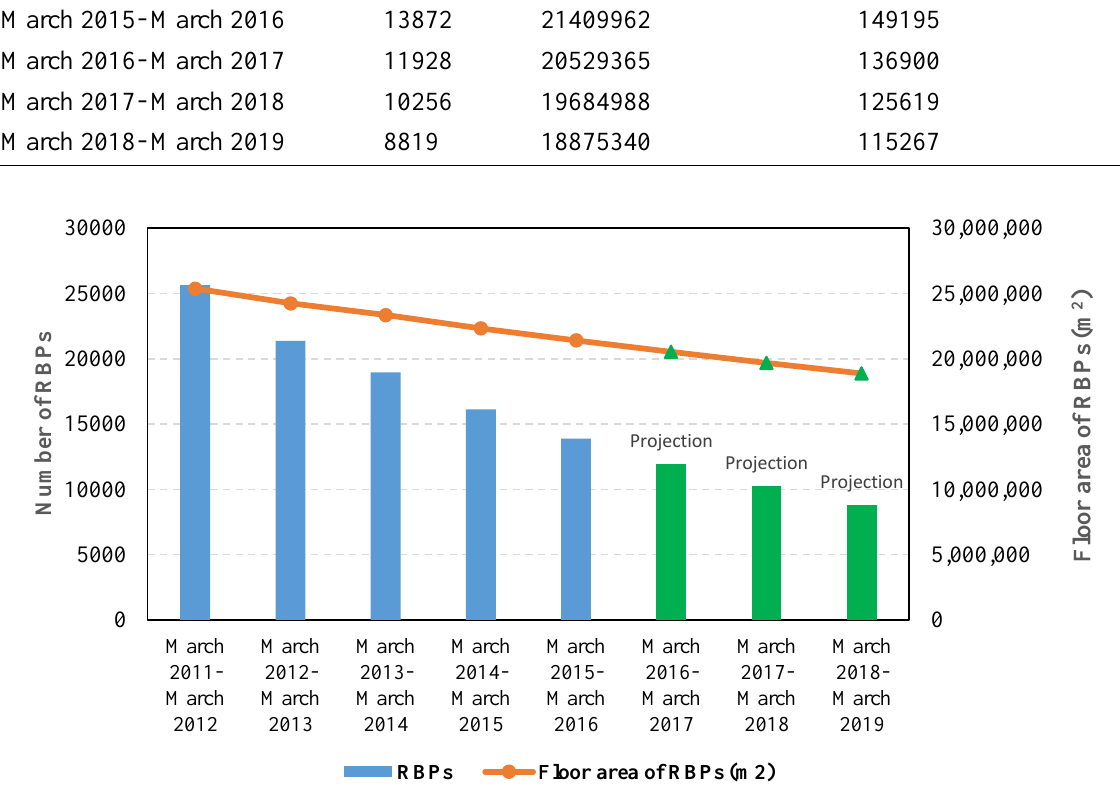
Figure 1 . Issued RBPs in last three years and predicted for